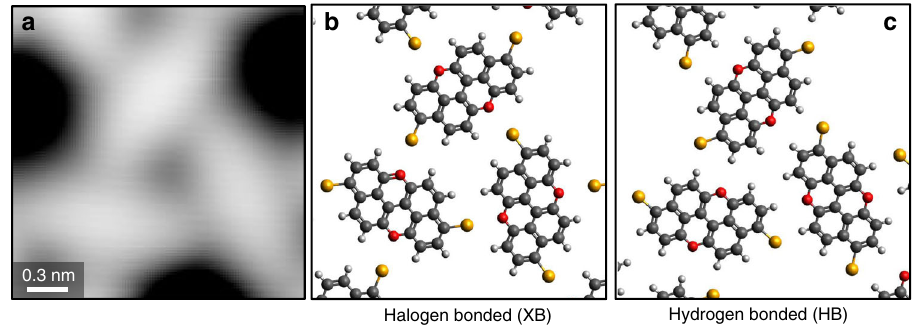
Fig. 3 Possible intermolecular bonding motifs stabilizing the kagome structure. a High magni fi cation STM image of the kagome structure highlighting one of its composing triangular sub-units. b Possible halogen bonded and c hydrogen-bonded structures for the kagome